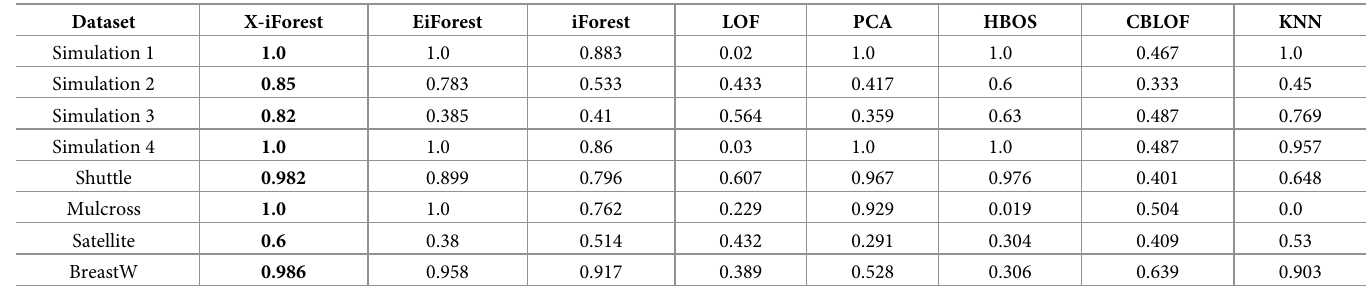
Table 3. ADR of X-iForest and other algorithms.